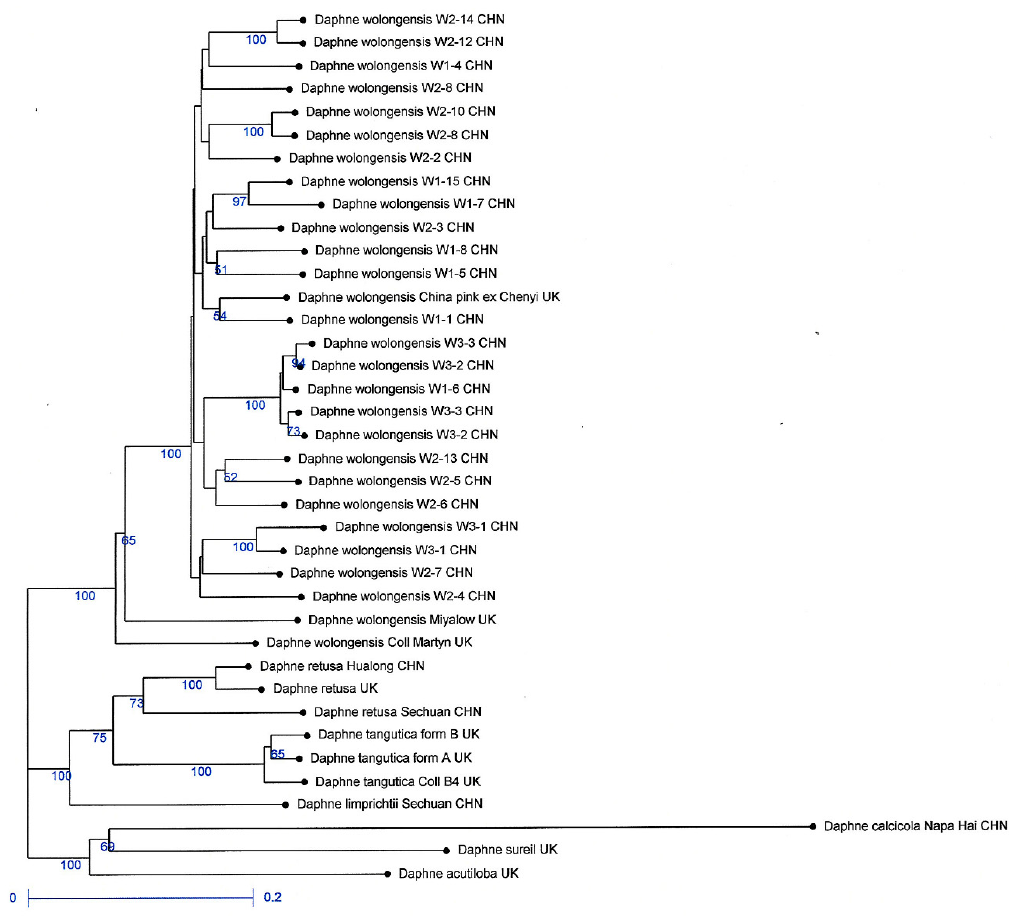
Figure 3. Dendrogram constructed using an unweighted neighbor joining clustering method based on a genetic distance matrix computed by means of Jaccard coefficients with 2000 bootstraps. There is a low level of genetic diversity within the three tested populations W1, W2, and W3 (Table 2). Only the variety China Pink was identified as pure D. wolongensis . The other analyzed varieties were derived from D. wolongensis by long-lasting isolation or hybridization with other Daphne species (Table 4). PCoA also shows the level of di ff erences between Daphne spp. and a low level of within species variability. The first three dimensions represent 50.5% of total variability detected in 38 Daphne spp. samples (Figure